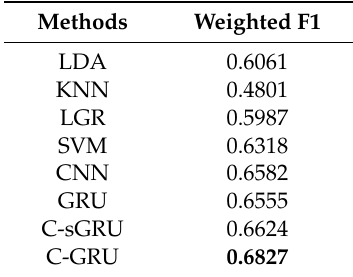
Table 2. Weighted F1 of the methods in IC classification.